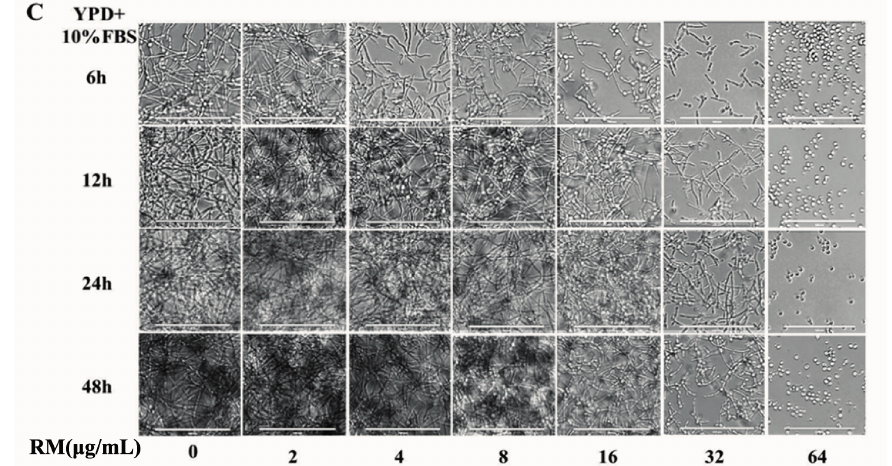
Figure 4. Effects of different concentrations of RM on hyphal formation. Exponentially growing C. albicans SC5314 cells were transferred to different hypha-inducing liquid media, ( A ) Spider medium; ( B ) Lee’s medium; ( C ) YPD + 10% FBS medium. The cellular morphology was photographed after incubation at 37 °C for 3.5 h. Bar = 100 μ m.